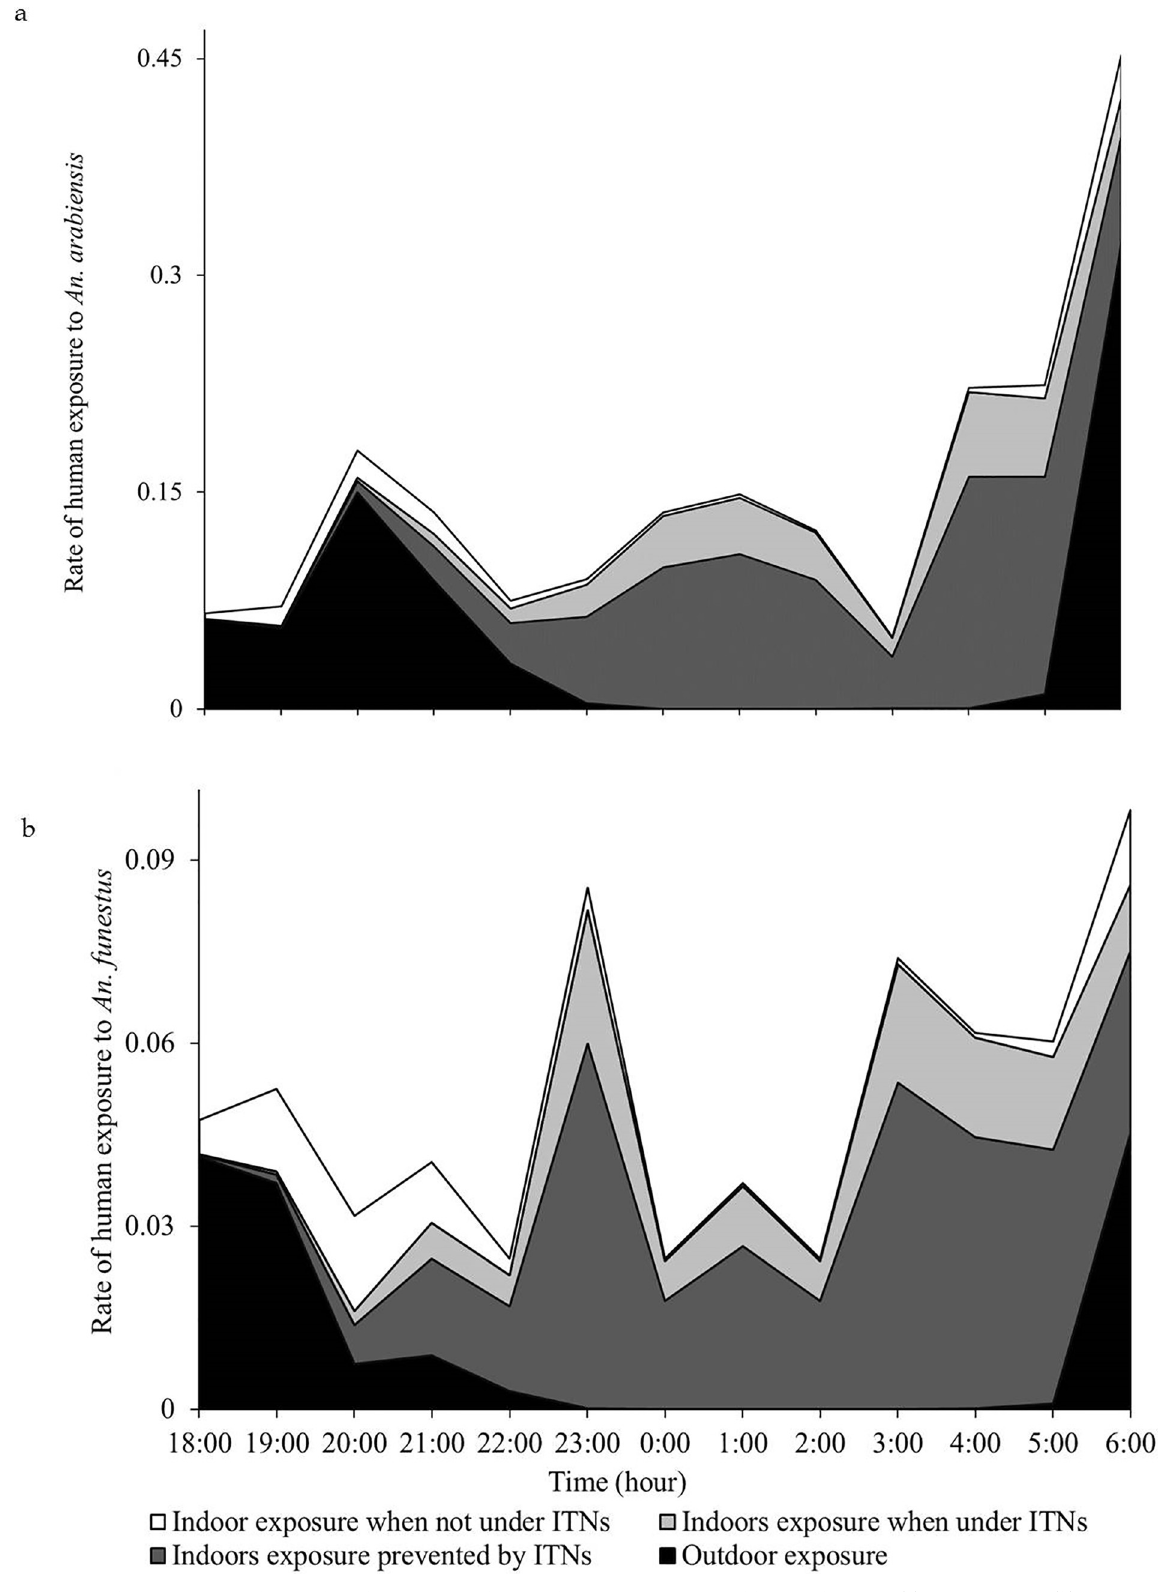
Fig 7. Hourly exposure to indoor and outdoor mosquito bites and proportions preventable using bed nets: (a) An . arabiensis ; (b) An . funestus